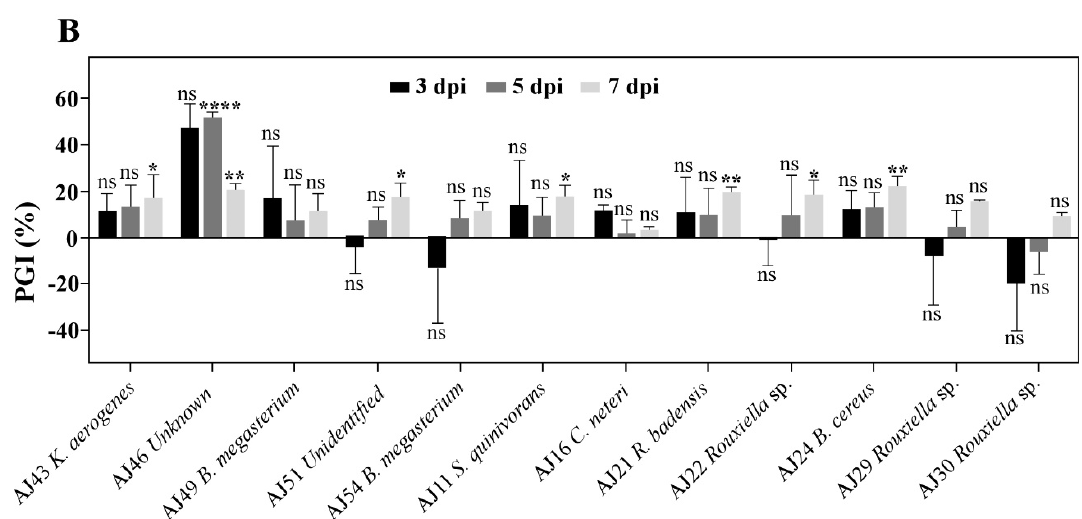
Figure 2. Antifungal activity of selected PGPR against B. mediterranea ( A ) and D. corticola ( B ). The percentage of fungal growth inhibition (% PGI) was determined at 5-, 7- and 9 dpi for B. mediterranea and at 3-, 5- and 7 dpi for D. corticola , considering the difference of pathogen growth area in the presence of each PGPR, in relation to the area of unchallenged pathogen (in the absence of PGPR, corresponding to PGI = 0%). Bars represent mean values ( n = 3) and error bars represent SE. Asterisks represent statistically significant differences in relation to control for each PGPR, at p ≤ 0.05 (*), p ≤ 0.01 (**), p ≤ 0.001 (***) and p ≤ 0.0001 (****). Non-significant differences are displayed with (ns).